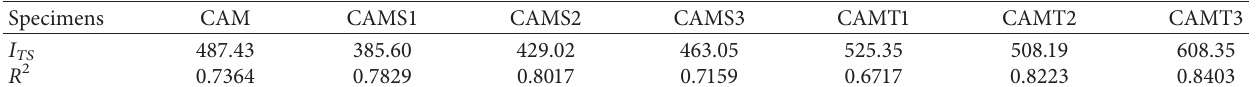
f ) and (( 1/ T ) − ( 1/ T r )) of (a) CAM, (b) CAMS1, (c) CAMS2, (d) CAMS3, (e) CAMT1, (f) T / Tr FC Table 8: Temperature sensitive factor of compressive